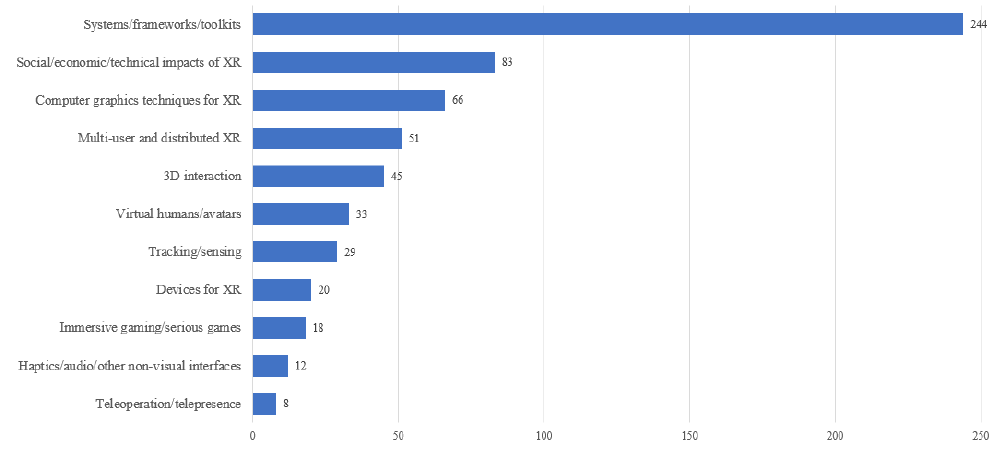
Figure 1. Overall distribution of publications per topic. Table 2. Most cited works for each event edition. Second column shows the current number of citations while the third one illustrates the highest h-index of the authors in that paper. We were not able to find h-index information for the SVR 2006 paper.